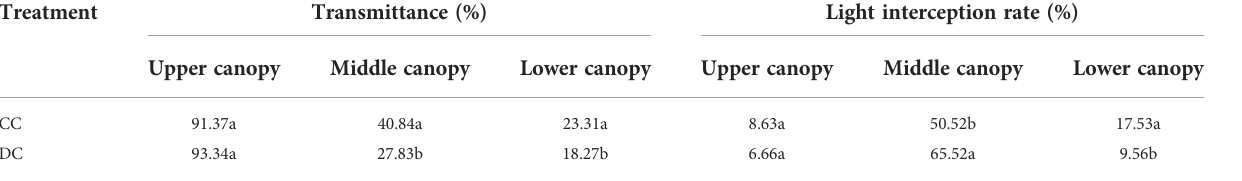
TABLE 3 Transmittance and light interception rate in different canopy.